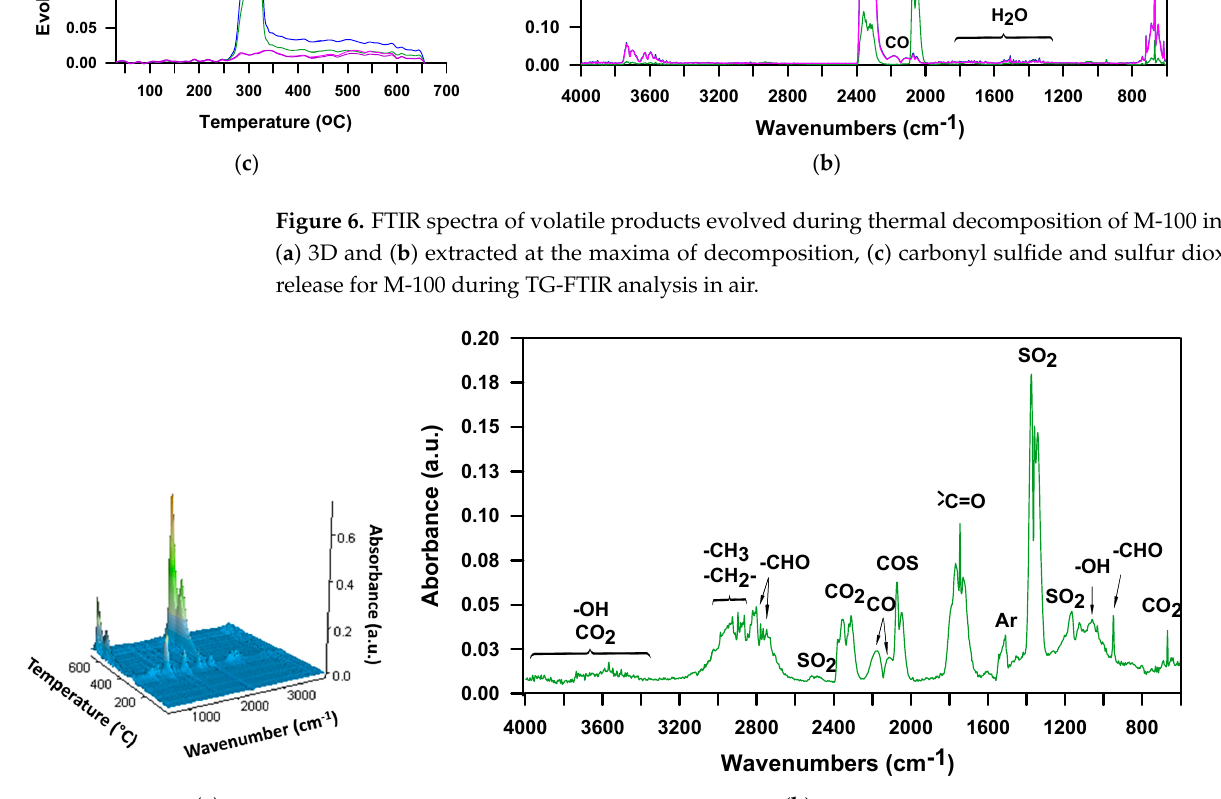
Figure 7. FTIR spectra of volatile products evolved during thermal decomposition of the DPHM-E diol in air: ( a ) 3D and ( b ) extracted at T max = 313 °C.